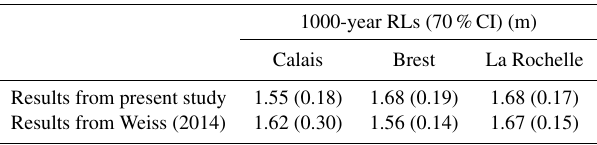
Table 2. Comparison of the 1000-year return levels with the 70% of the confidence interval width (70%CI) in brackets obtained herein with those of Weiss (2014).